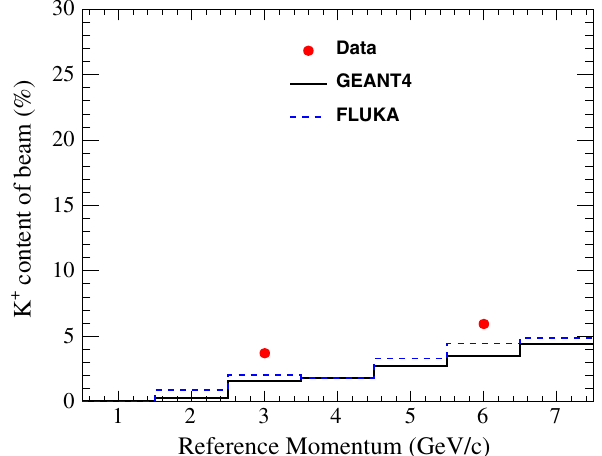
FIG. 23. Measured and simulated beam content for kaons. Data were only taken for 3 and 6 GeV =c , using the W target for 3 GeV =c and the Cu target for 6 GeV =c . A satisfactory agree- ment is demonstrated, since the data seem to agree within a maximum of factor of two with the simulations, at 3 GeV =c , while an even better agreement is observed at 6 GeV =c .